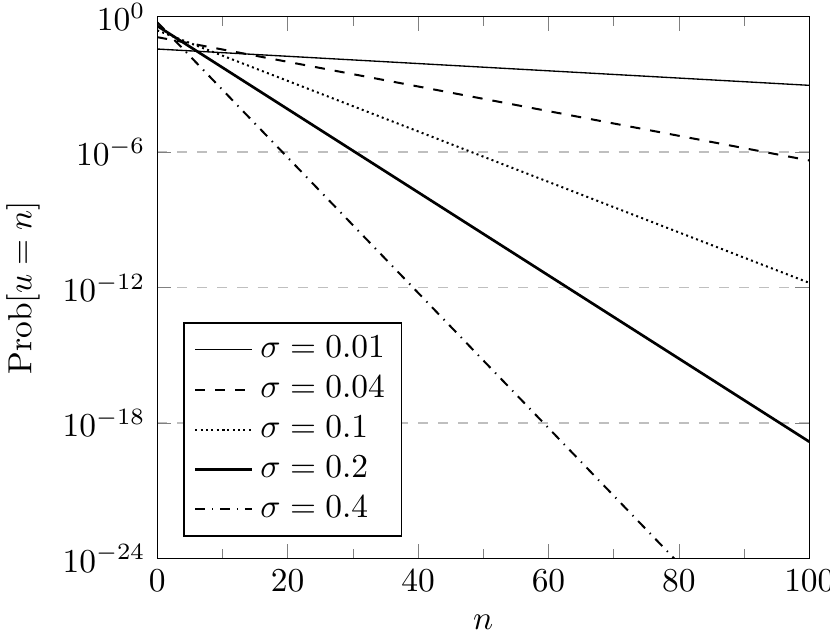
Figure 12. Tail distribution of the system content Prob [ u = n ] versus n for Poisson service times with µ = 0.75, Poisson arrivals with λ = 1 and different values of σ